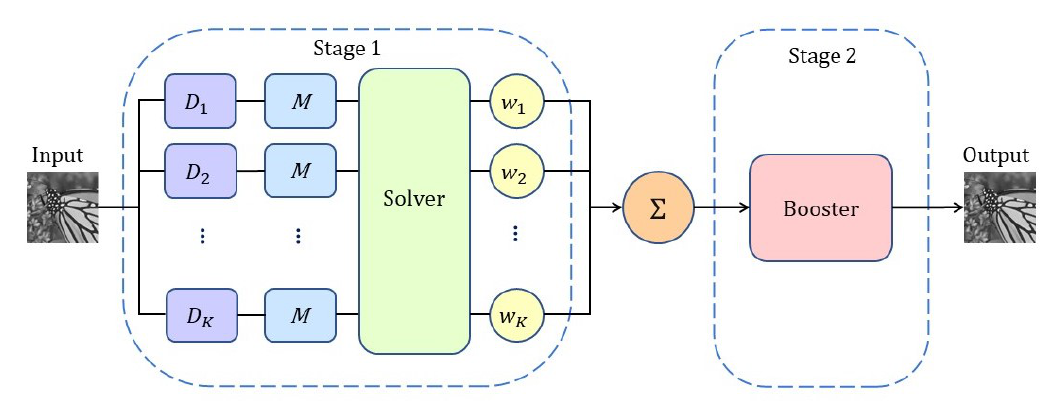
Figure 1. The architecture of CsNet [28]. D 1 , D 2 ,..., D K are the initial denoisers, M refers to the estimator used to estimate the mean squared error (MSE) of each initial denoised image, w 1 , w 2 ,..., w K are the generated weights, which are determined by the solver by finding a solution to a convex optimization